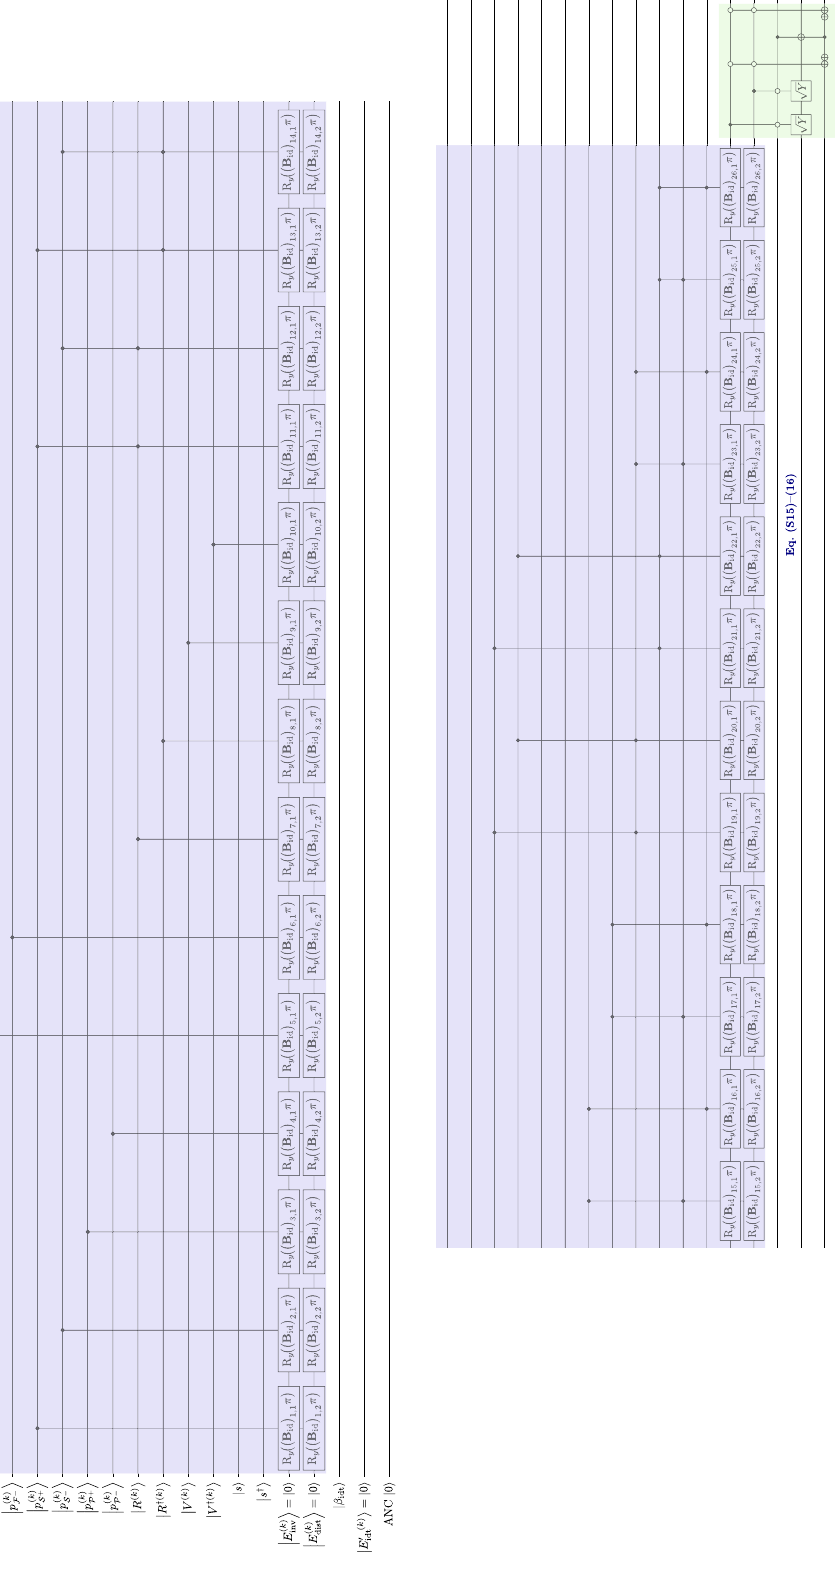
Figure 10. Extract of quantum algorithm for the involvement–distance